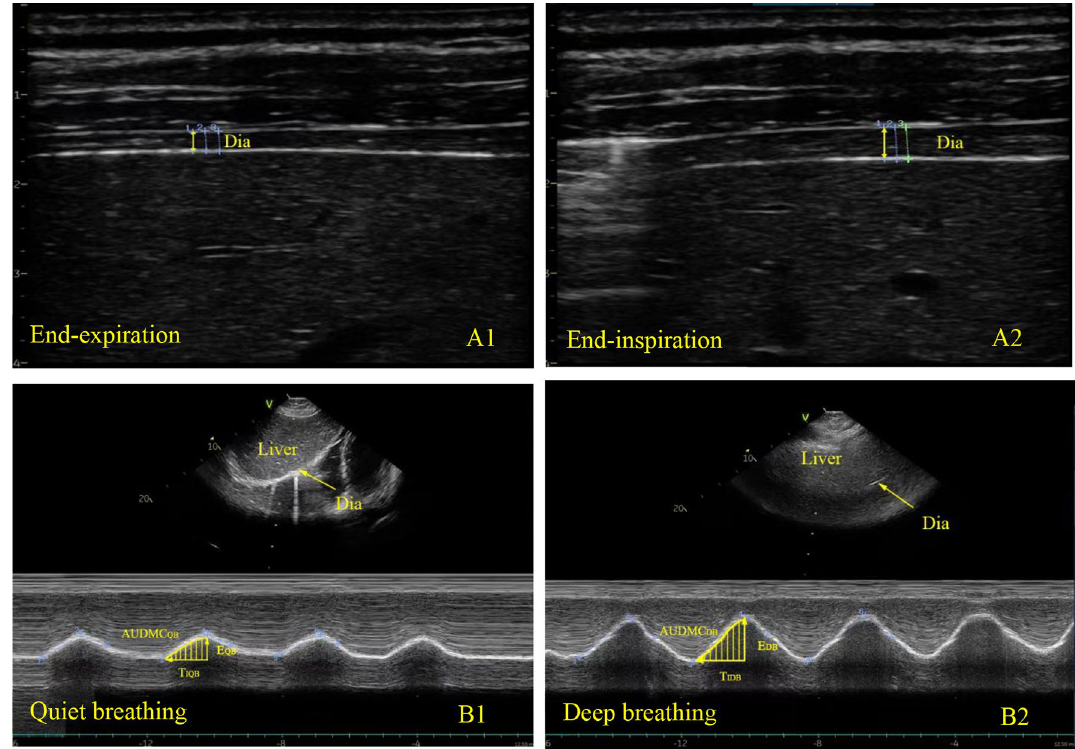
Figure 1. Diaphragmatic thickness measured by B mode ultrasound at end-expiration ( A1 ) and end-maximum inspiration ( A2 ). Diaphragmatic mobile curve in M mode of ultrasound was shown during quiet breathing ( B1 ) and deep breathing ( B2 ). Parameters were measured at three consecutive breathing cycles. EQB, excursion during quiet breathing; EDB, excursion during deep breathing; TI, inspiratory time; AUDMC, area